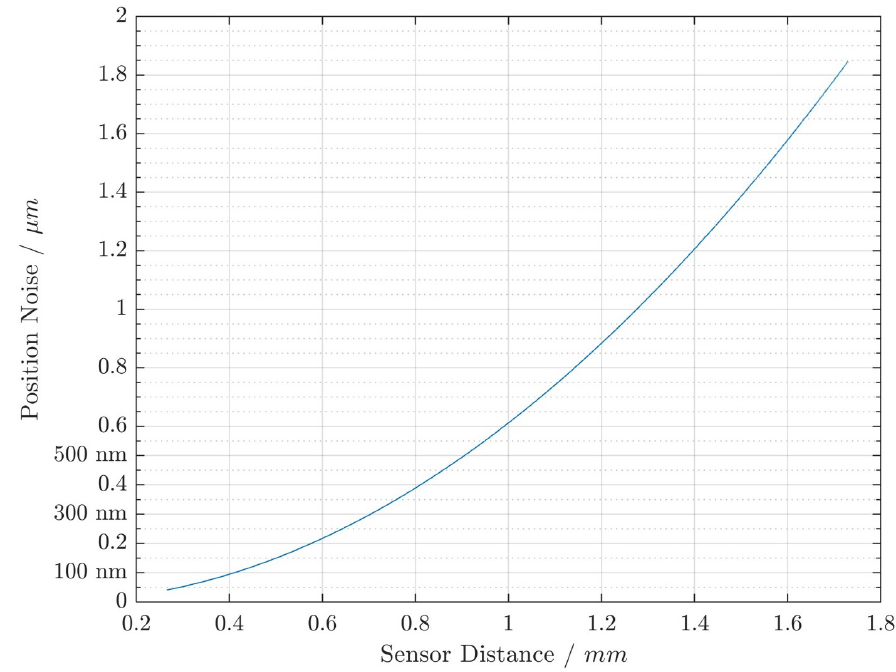
Figure 10. Illustration of achieved position noise dependent on the sensor distance using a bandwidth of B meas =